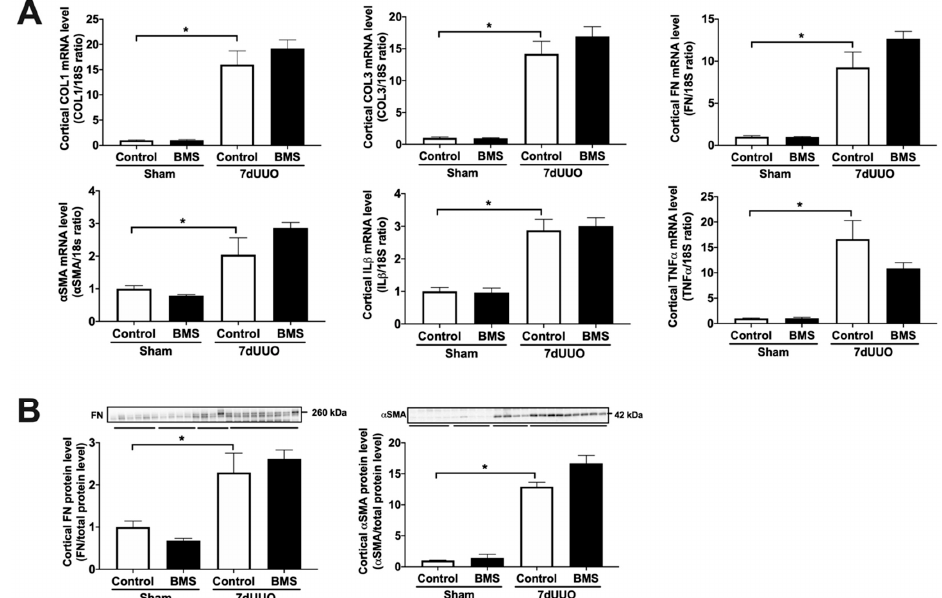
Figure 4. 1-Methyl-D-tryptophan solely reduced collagen 3A1 gene expression in UUO mice. Mice were subjected to 7 days of unilateral ureteral obstruction (UUO) and treated with 1-methyl-D-tryptophan (10 mg/mL). ( A ) Relative mRNA expression of the fibrosis markers collagen 1A1 (COL1), collagen 3A1 (COL3), fibronectin (FN), and α -smooth muscle actin ( α SMA), and the inflammation markers tumor necrosis factor alpha (TNF α ) and interleukin 1 beta (IL-1 β ), all normalized to 18S. n = 6–11. ( B ) Protein expression of fibronectin (FN) and α -smooth muscle actin ( α SMA) was studied using western blot, corrected for total protein levels. n = 6–11. Data are presented as mean ± SEM. * p < 0.05.